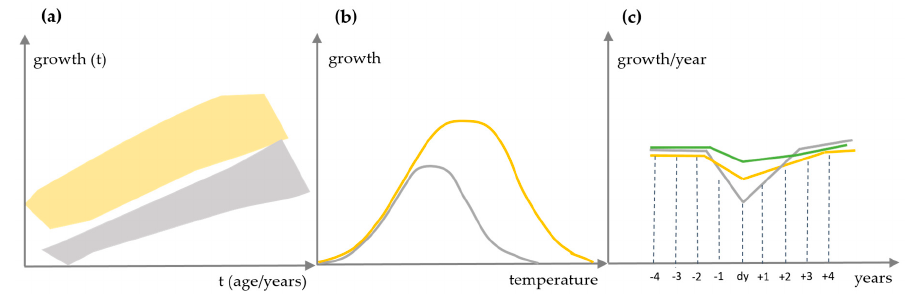
Figure 12. Schematic representation of the main results. ( a ) Higher growth level of oak (yellow) over time (t) against traditional growth assumptions (grey). ( b ) Extension of ecological niche concerning temperature and growth (grey: traditional, yellow: real). ( c ) Similar resilience and resistance to drought events of oak over a broad range of climate zones (grey: Germany, green: Italy, yellow: South Africa); years on the X -axis show: the years before ( − 4 to − 1), the drought years (dy), and the years after the drought (+1 to +4).